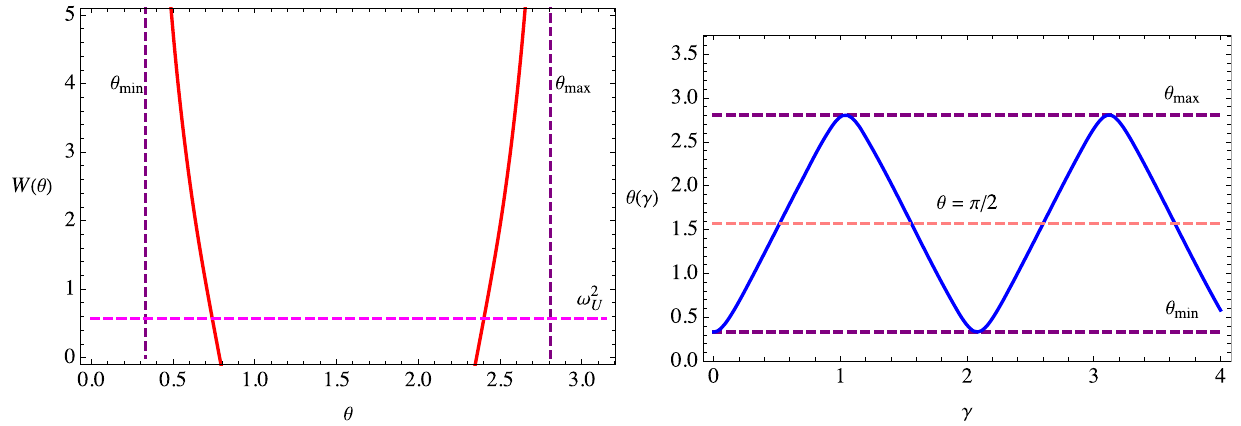
Fig. 7 The angular effective potential and the temporal evolution of the coordinate θ for the case of ˜ η > 0, plotted for Q = 9 M 2 and f θ = 1 M 2 . To plot θ(γ) , we have considered ω 0 = 0 . 755